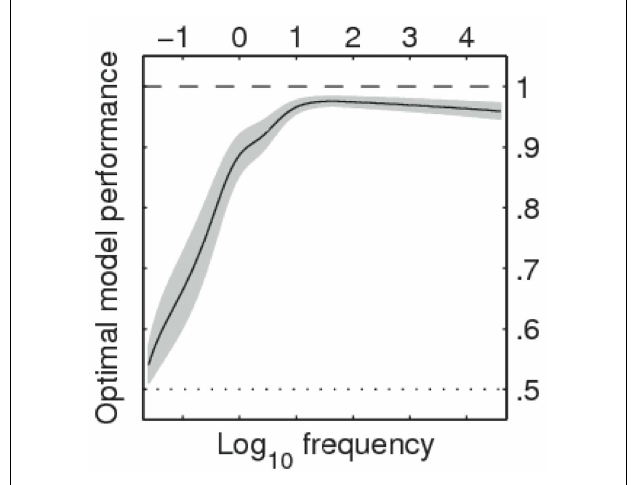
FIGURE 3 | Estimated range for optimal model performance as a 6-knot restricted cubic spline function of log-word frequency per million words (Keuleers et al., 2010a). Horizontal dotted line corresponds to chance level